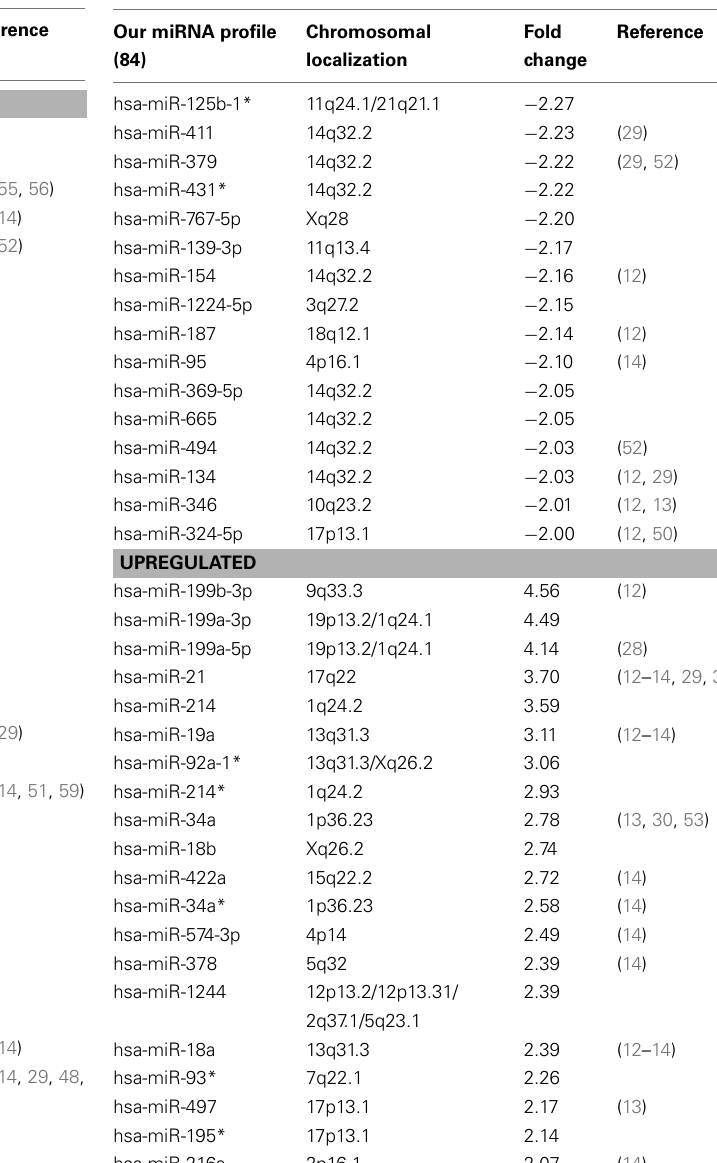
Table 3 | Deregulated miRNA in desmoplastic medulloblastoma compared to normal